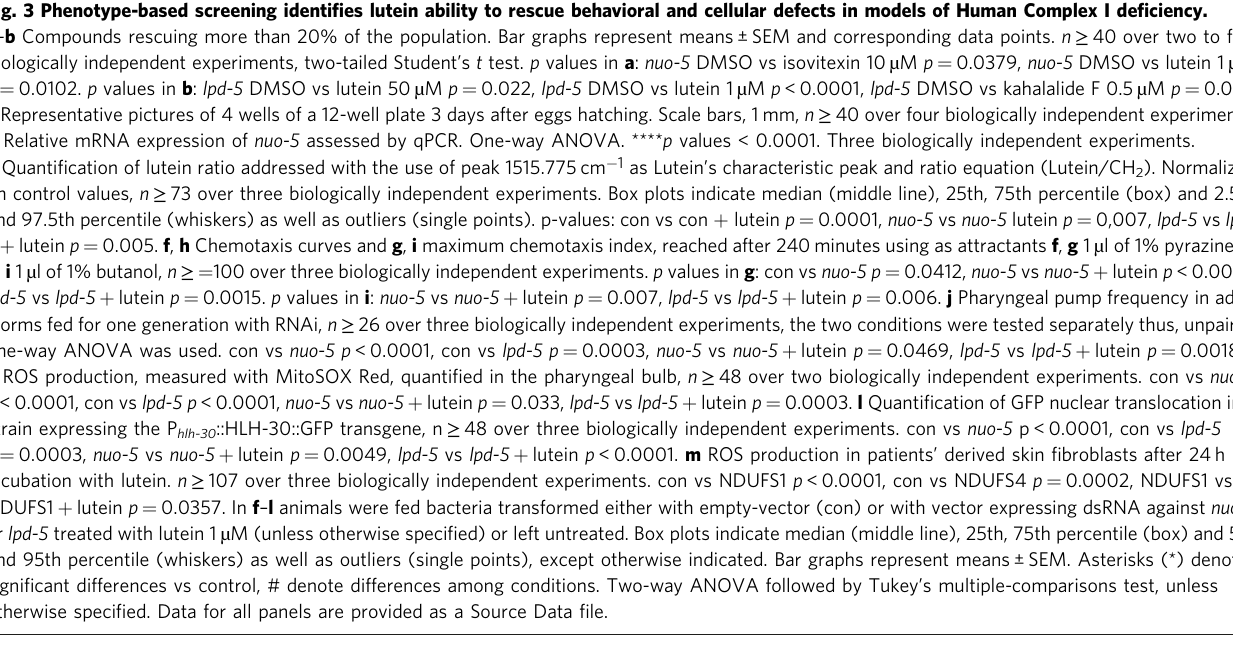
Fig. 3 Phenotype-based screening identi fi es lutein ability to rescue behavioral and cellular defects in models of Human Complex I de fi ciency. a – b Compounds rescuing more than 20% of the population. Bar graphs represent means ± SEM and corresponding data points. n ≥ 40 over two to fi ve biologically independent experiments, two-tailed Student ’ s t test. p values in a : nuo-5 DMSO vs isovitexin 10 µ M p = 0.0379, nuo-5 DMSO vs lutein 1 µ M p = 0.0102. p values in b : lpd-5 DMSO vs lutein 50 µ M p = 0.022, lpd-5 DMSO vs lutein 1 µ M p < 0.0001, lpd-5 DMSO vs kahalalide F 0.5 µ M p = 0.001. c Representative pictures of 4 wells of a 12-well plate 3 days after eggs hatching. Scale bars, 1 mm, n ≥ 40 over four biologically independent